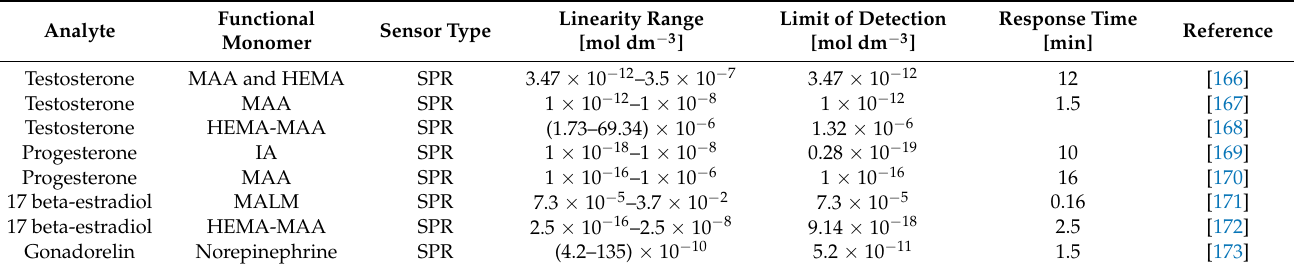
Table 5. MIP plasmonic sensors for hormone